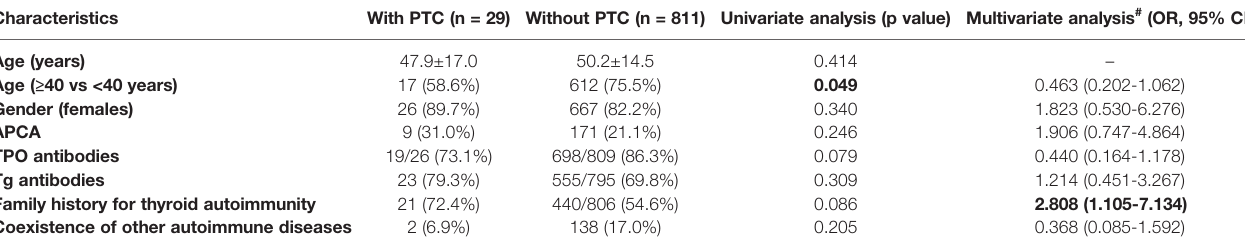
TABLE 3 | Univariate and multivariate analysis of factors associated with papillary thyroid carcinoma in HT patients (n = 840).